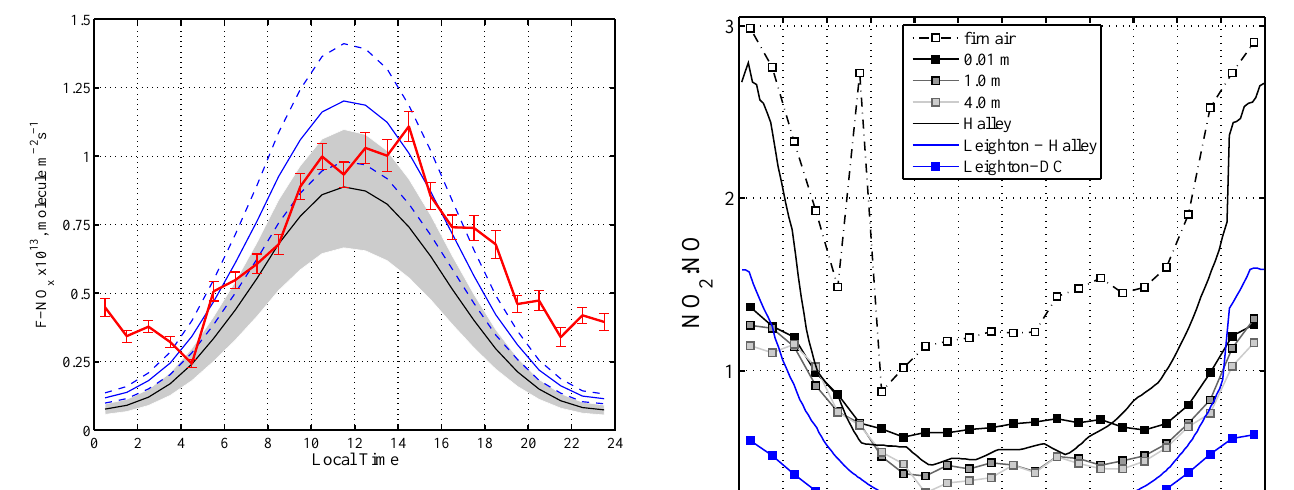
Fig. 10. The median diurnal variation of NO x flux (F-NO x ) at Dome C compared to model calculations: F-NO x during 22 December 2009–28 January 2010 observed between 0.01 and 1m (red line) and its uncertainty (error bars indicating the 1- σ standard error of √ N , where σ is the random er- the median calculated as 1.253 σ/ Fig. 11. The median diurnal cycle of the NO 2 : NO ratio during ror of 10-min flux values and N is the number of samples per 1-h 22 December 2009 to 28 January 2010 shows significant deviations bin, e.g. Maindonald and Braun, 2003). Modeled F-NO x during 22 from Leigthon steady-state at Dome C. Halley observations (black December 2009–21 January 2010 from NO − photolysis only (Re- 3 line) are shown for comparison (Bauguitte et al., action R10, black line) and including also contributions from NO − 2 photolysis (Reaction R12) assuming a maximum NO − concentra- 2 tion in snow of 0.5ppbw (blue line). The shaded area and dashed lines show the range of F-NO x due to the spatial variability in NO − 3 snow profiles at Dome C reported in France et al. (2011).